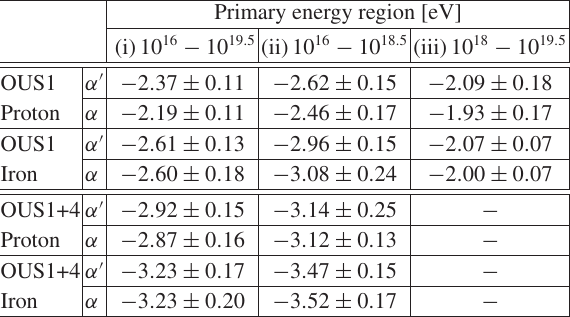
Table 2. The spectral index α (cid:2) and α